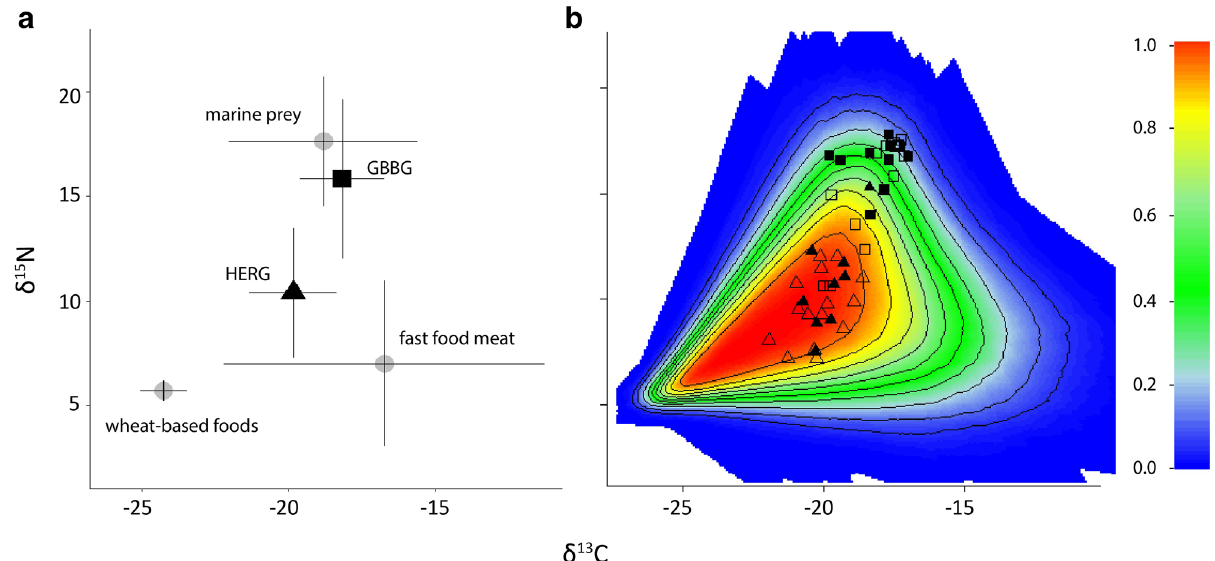
Figure 3. ( a ) Biplot of whole blood δ 15 N and δ 13 C for great black-backed gulls (black squares) and herring gulls (black triangles) and potential food sources (grey circles). Differences in δ 13 C and δ 15 N between great back-backed and herring gulls were tested for significance using a Wilcoxon-rank sum test (α = 0.05). ( b ) Simulated mixing region from potential food sources and probability contours. Isotopic positions of gulls with corresponding GPS tracks are shown as filled symbols (squares for great black-backed and triangles for herring gulls), and those without GPS tracks as open symbols. Contour lines are placed at 10% intervals except for the outermost contour, which is at the 5%